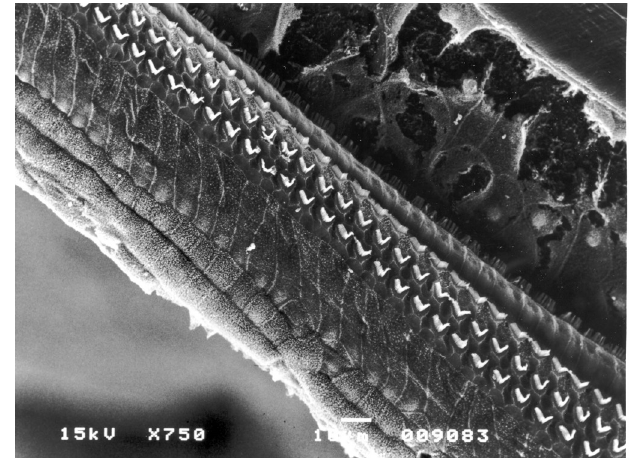
Figure 2. Cochlea basal ramp belonging to an animal from the oto- silicate group after 30 days, where we can see all the external and internal hair cells.